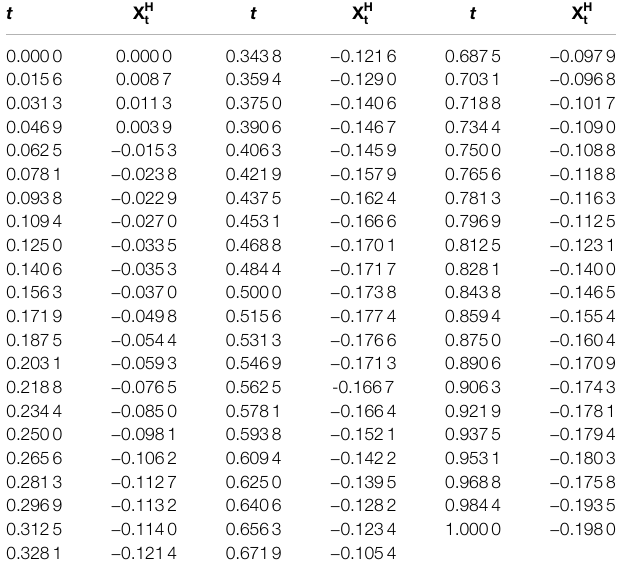
TABLE 3 | Data of X H t with θ (cid:1) 100 and H (cid:1) 0.7